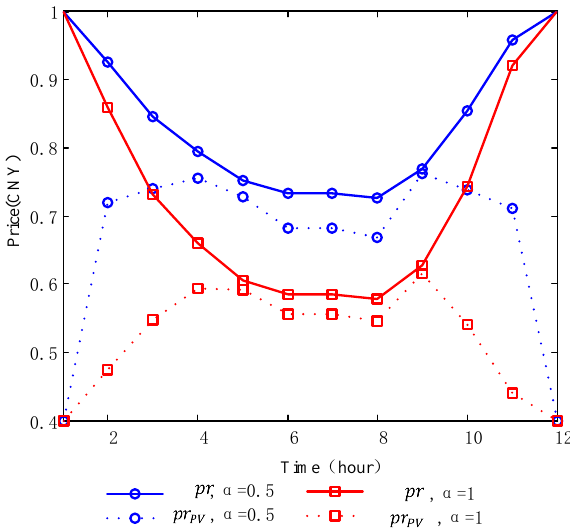
Figure 13. Impact of α on internal price in PVC.